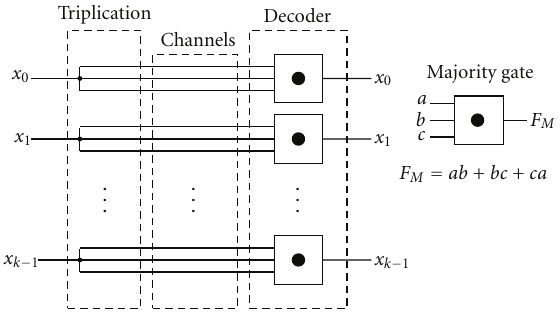
Figure 3: Triplication error correction stage of SCG coding